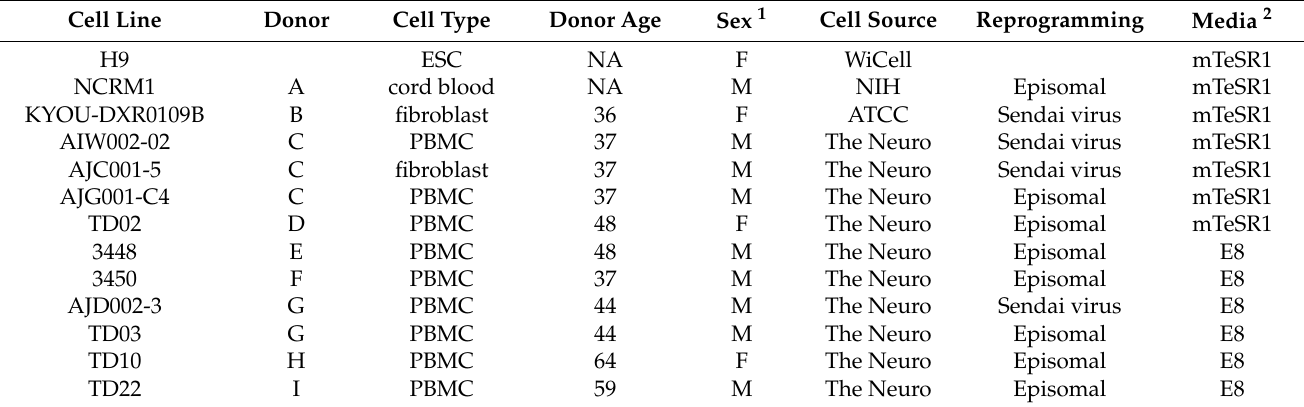
Table 1. Overview of